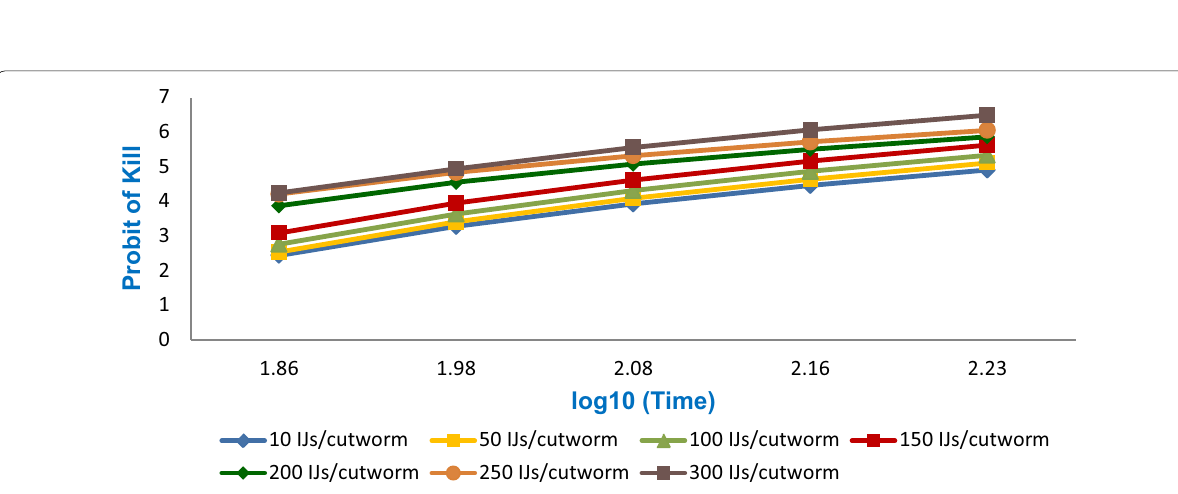
Fig. 4 Time response curve of A. ipsilon larvae exposed to S. aciari during different time intervals and